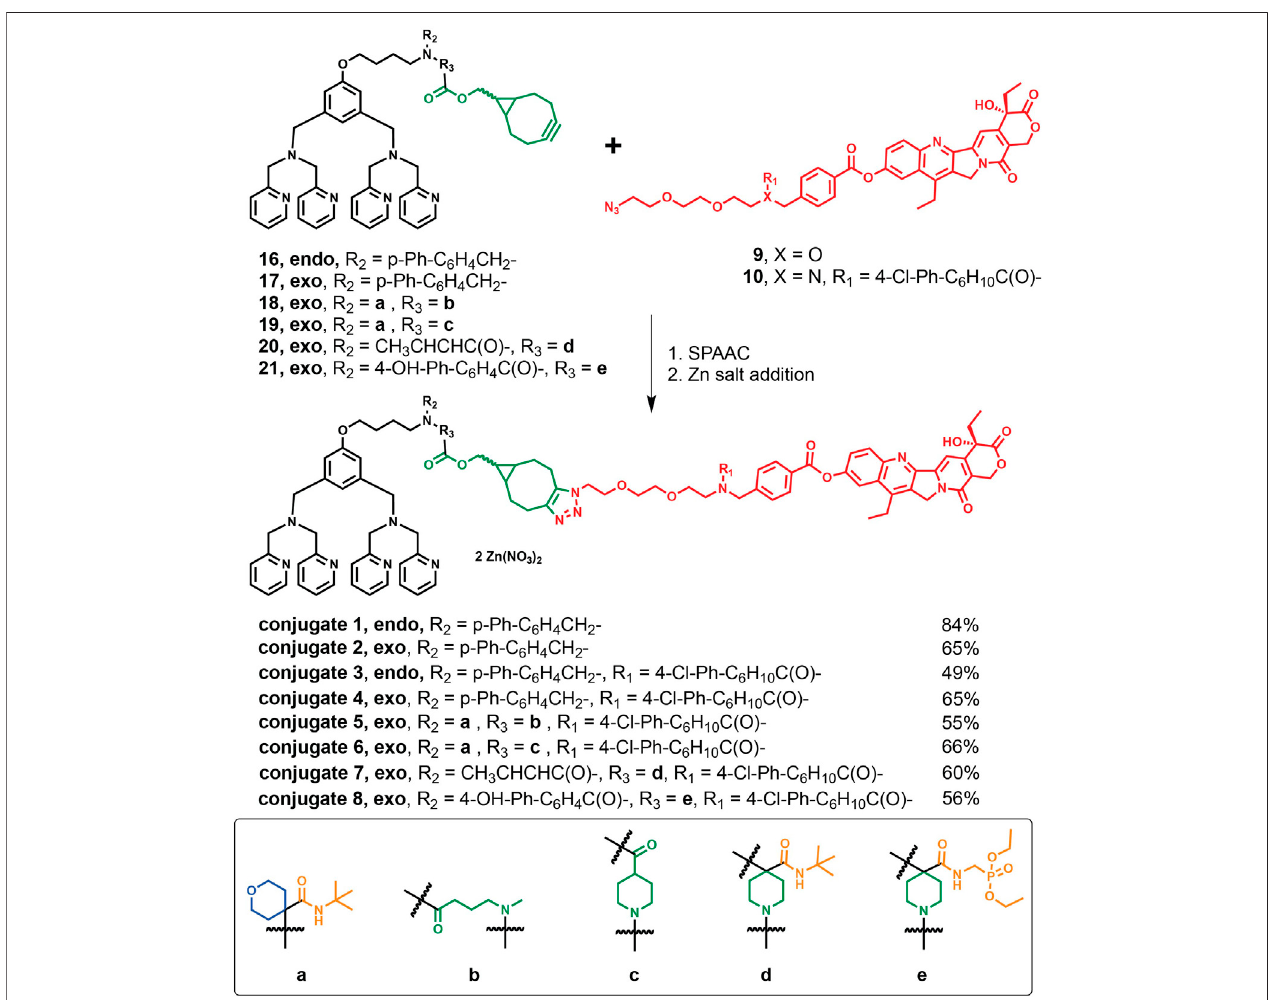
TABLE 2 | Pharmacokinetic pro fi les of conjugates 4 – 8 in male ICR mice ( n = 3) at 5 mg/kg with intravenous administration. Pharmacokinetic studies of conjugates in male ICR